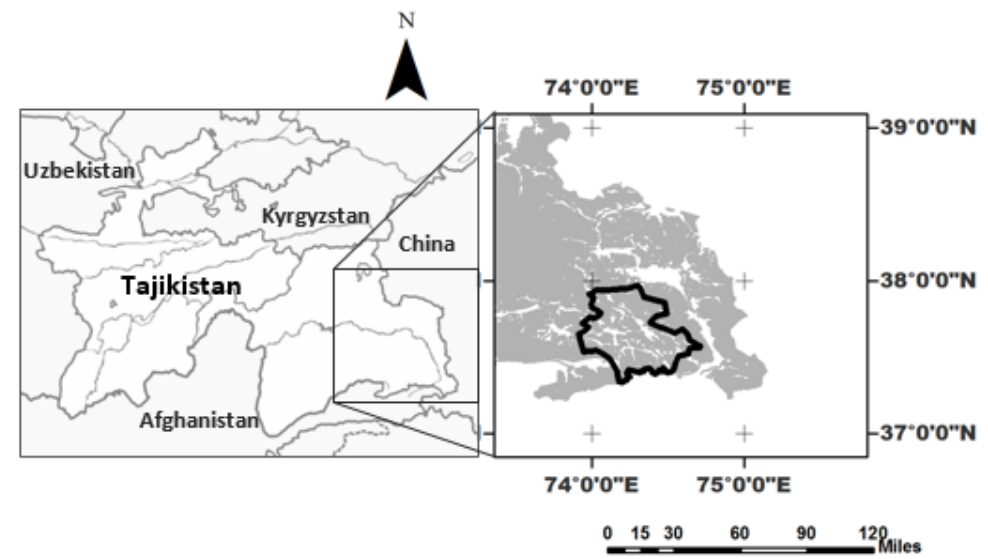
Figure 1. Location of the study area in the southeastern region of Tajikistan, based on a single Landsat 8 OLI scene from 15 July 2014.